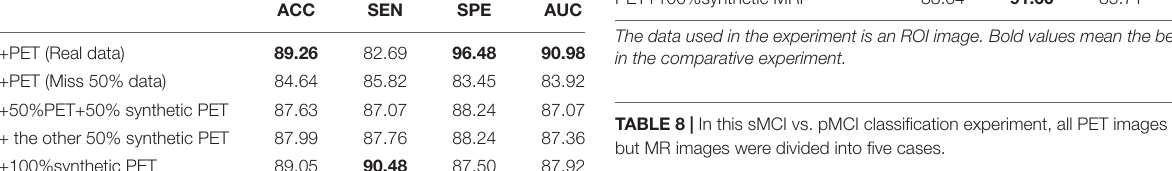
ACC SEN SPE AUC